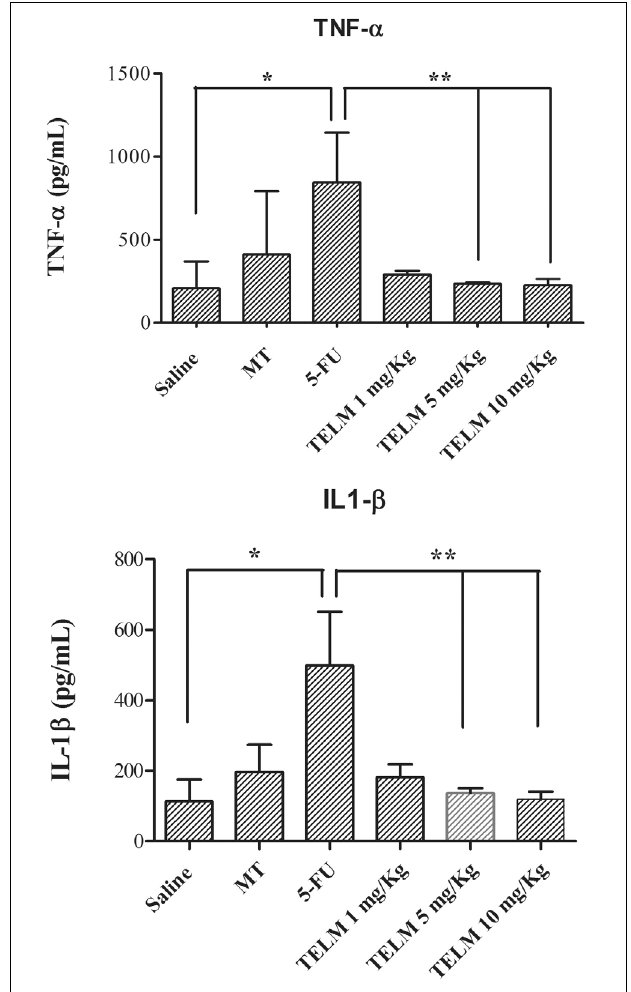
FIGURE 3 | Levels of tumor necrosis factor (TNF)- α and interleukin (IL)-1 β cytokines in the oral mucosa of hamsters with oral mucositis (OM). The saline group consists of animals without OM. The mechanical trauma (MT) group consisted of hamsters that received excoriations of the oral mucosa, without 5-fluorouracil (5-FU). The 5-FU group received 5-FU, was subjected to MT and was treated with saline i.p. The TELM groups received 5-FU, were subjected to MT, and received TELM i.p. at one of three doses (1, 5, or 10 mg/kg). The results are presented as the mean ± standard error of the mean ( n = 5). ∗ p < 0.05 vs. the saline group, ∗∗ p < 0.05 vs. the 5-FU group (analysis of variance with Tukey’s